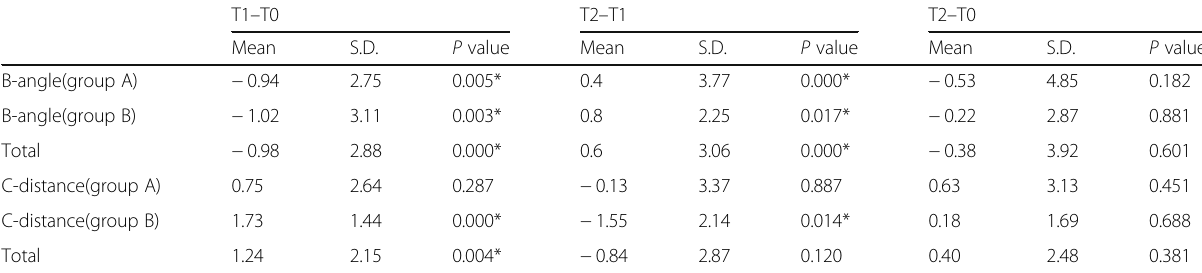
Table 6 Positional changes of the condyle on the frontal